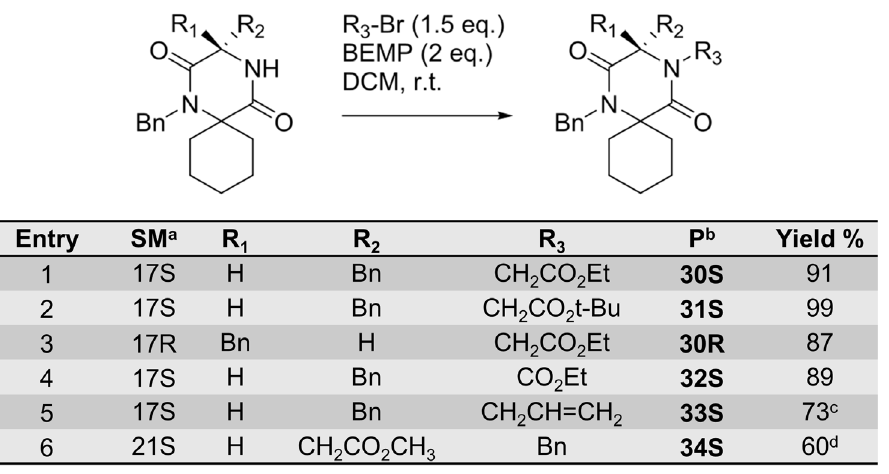
Fig 11. N 4-Alkylation of spiro-2-DKPs 30 –